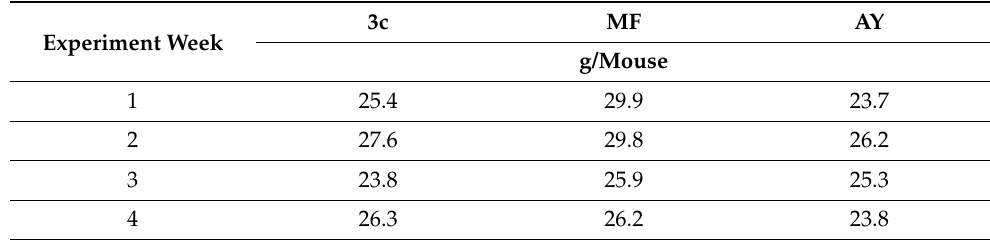
Table 2. Food consumption by mice during the experiment. Data represented as food intake (total amount of standard chow, cookies, and lard) in g per a mouse in the group.